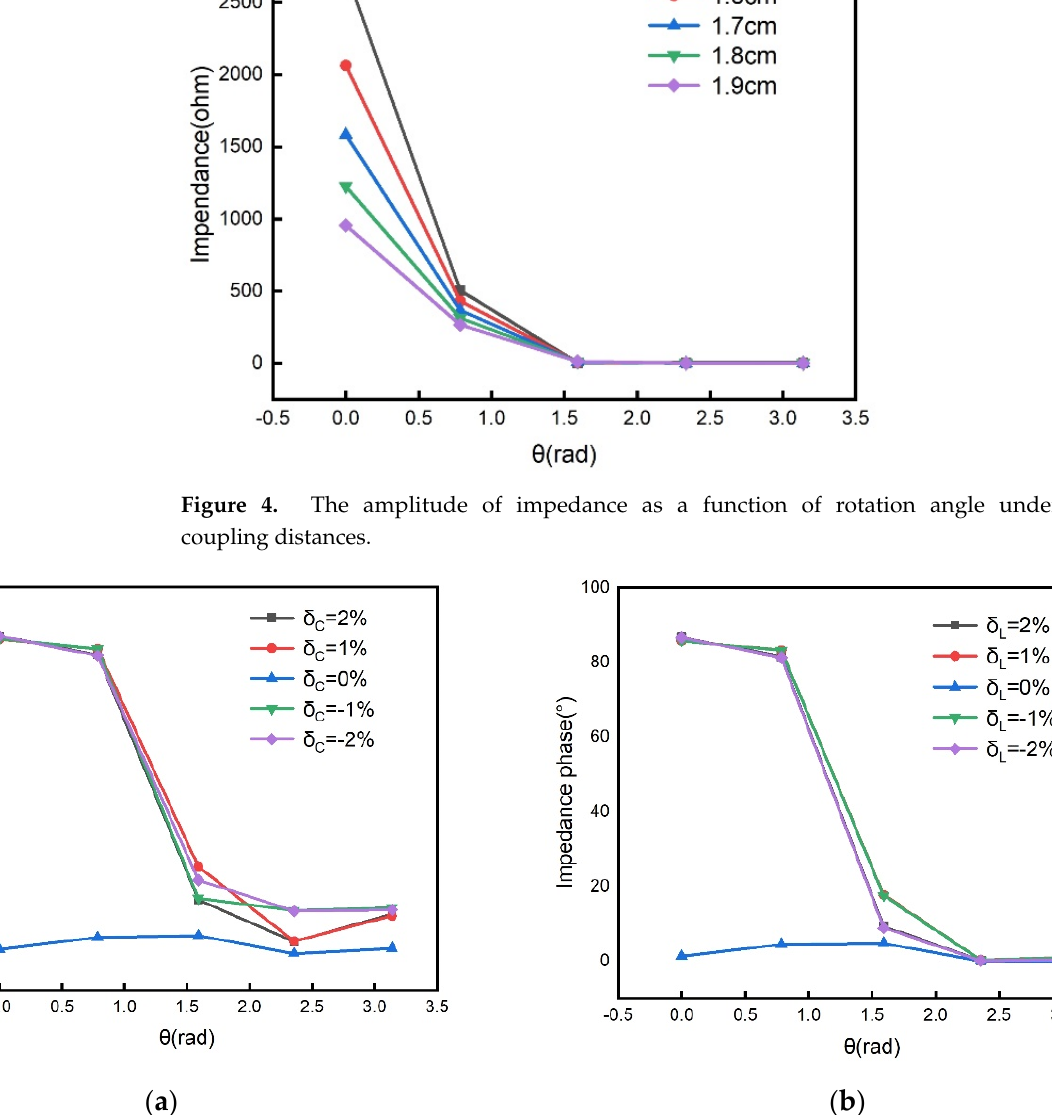
Figure 5. The effect of component deviations on the impedance phase: ( a ) the additional phase of the impedance as a function of rotation angle under different capacitance relative errors; ( b ) the additional phase of the impedance as a func–tion of rotation angle under different inductance relative errors.